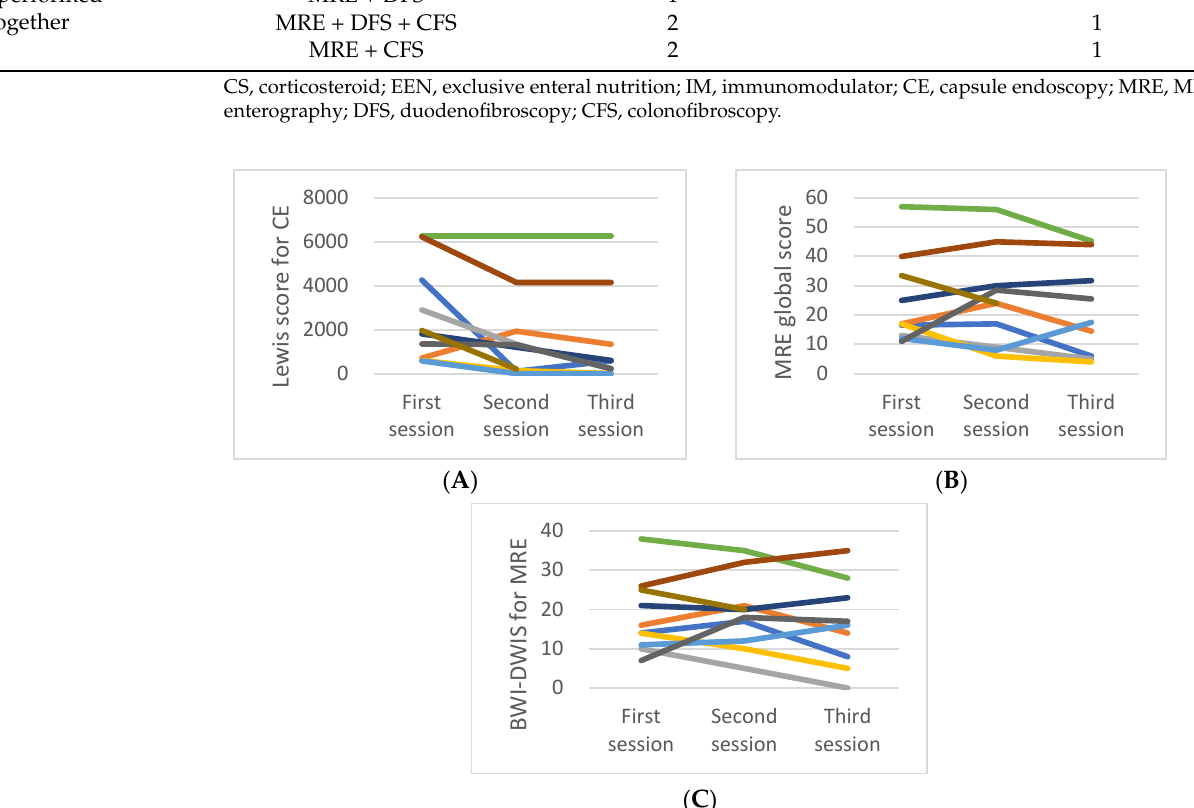
Table 1. Treatment of patients before each session, CE preperation and test performed together.